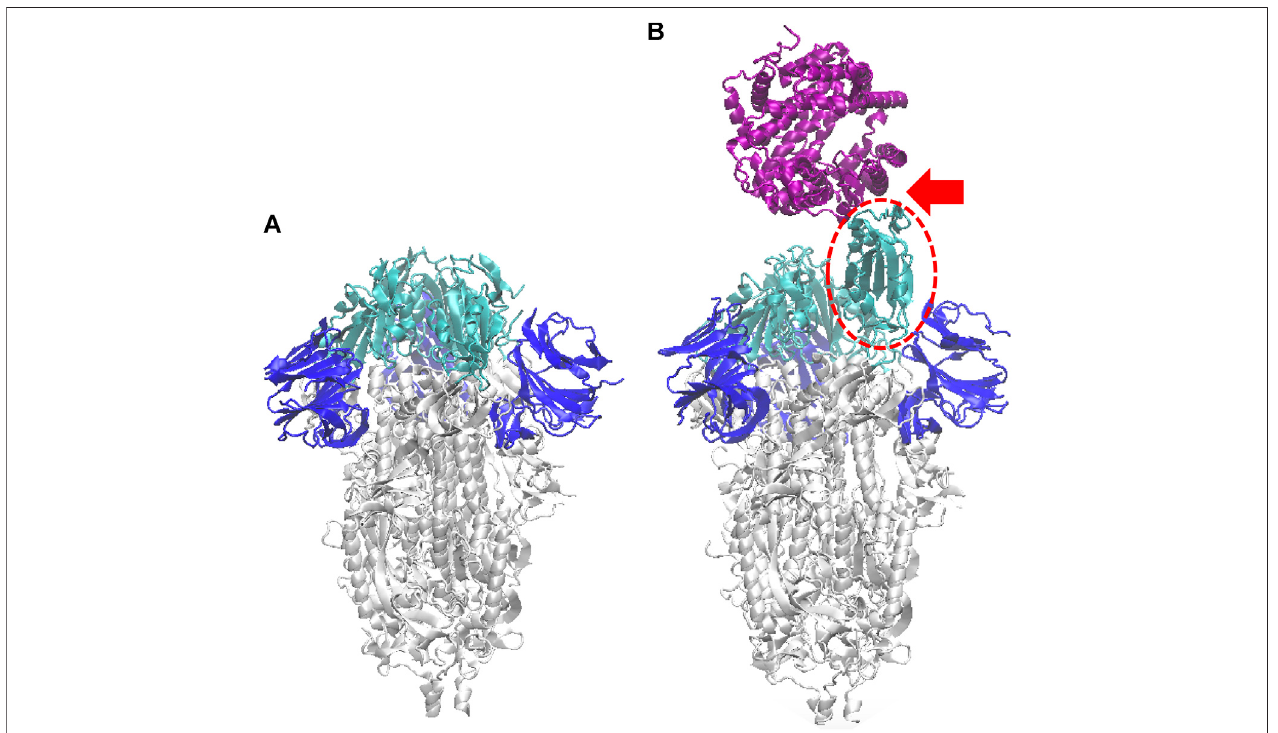
FIGURE 1 | Ribbon model of the SARS-CoV-2 S-protein (glycans omitted for clarity), in the closed con fi guration (A) , and with one monomer open (B) (dashed red oval).Hereandinthefollowing fi gures,theS1-RBDsubdomainofeachmonomerisdepictedincyan,andtheNsubdomaininblue.In (B) alsotheACE2humanreceptor is represented (purple), interacting with the S1 domain in open con fi guration (see red arrow); atomic structure obtained by aligning the pdb 6VSB (Wrapp et al., 2020), with the co-crystallized S-protein RBD and ACE2 structure, pdb 6M0J (Lan et al.,